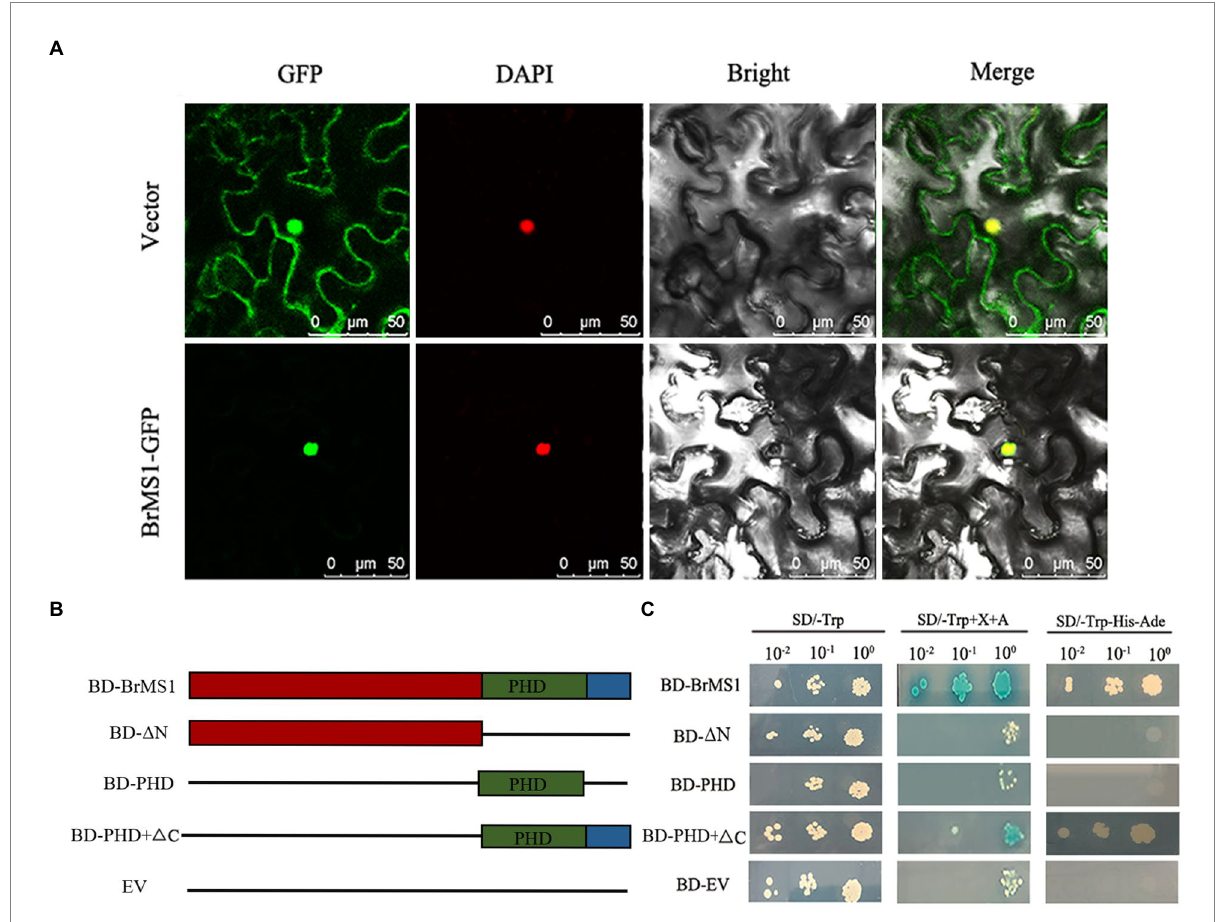
FIGURE 9 Subcellular localization and transcriptional activation assay of the BrMS1. (A) Subcellular localization of BrMS1 in Tobacco leaf. DAPI staining was used as a nuclear marker. Scale bar, 50 μ m. (B) The schematic diagram displays various truncated constructs and pGBKT7 empty vector used for the transcriptional activation assay. (C) Transcriptional activation assay of BrMS1 in the Y2H yeast strain. BD GAL4–DNA binding domain, EV empty vector. The BD–EV used as a negative